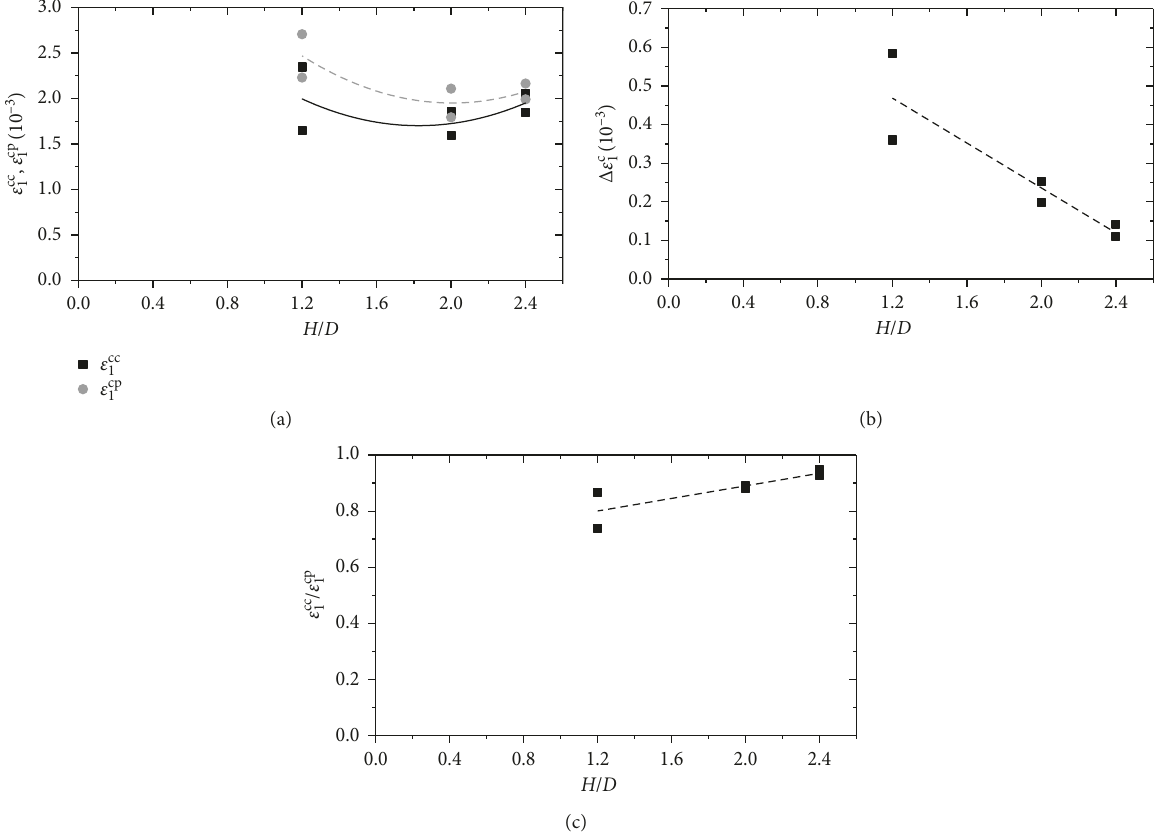
Figure 7: (a) Relationship between the crack closure and peak crack axial strains and the H / D ; (b) relationship between the Δ ε c (c) relationship between the ε cc